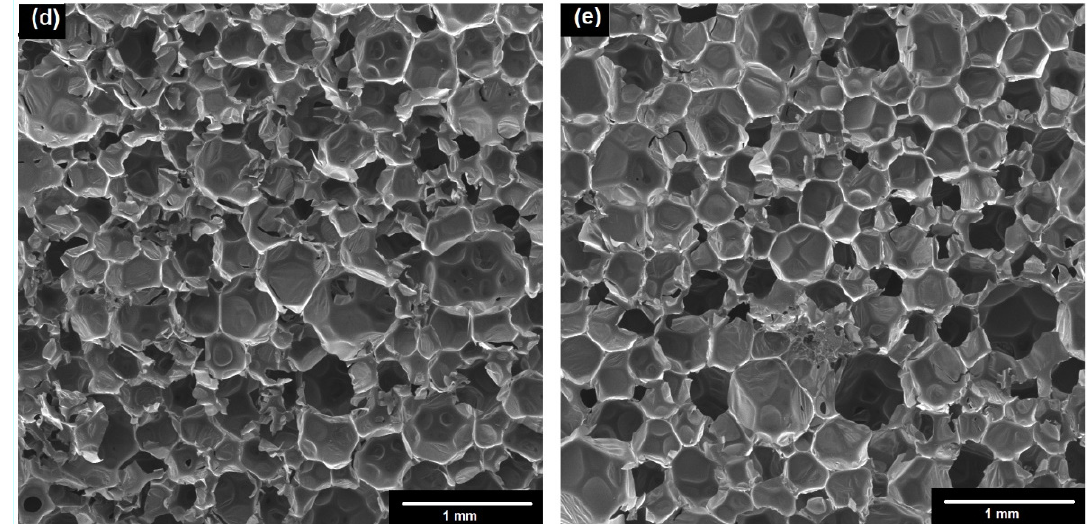
Figure 10. SEM photos of: ( a ) PUR; ( b ) PUR/5% C I; ( c ) PUR/5% mC I; ( d ) PUR/5% NC II; ( e ) PUR/5% mNC II.